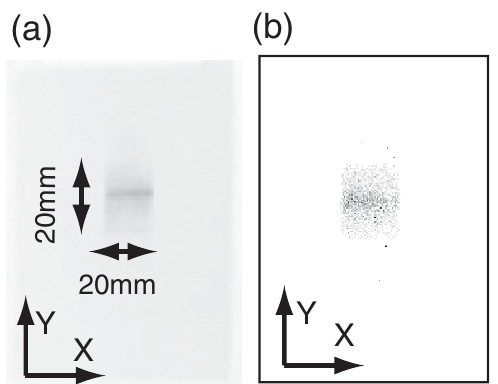
FIG. 4. (Color) (a) Observed beam pattern with reinstalled exit slit of the monochromator at plane ‘‘f’’ whose baseline spot size is (cid:2) 20 ð horizontal Þ (cid:4) 20 ð vertical Þ mm . (b) PARMILA simulated beam pattern at the same location as for (a) with the same scale. The x and y axes in both panels correspond to those in Fig.